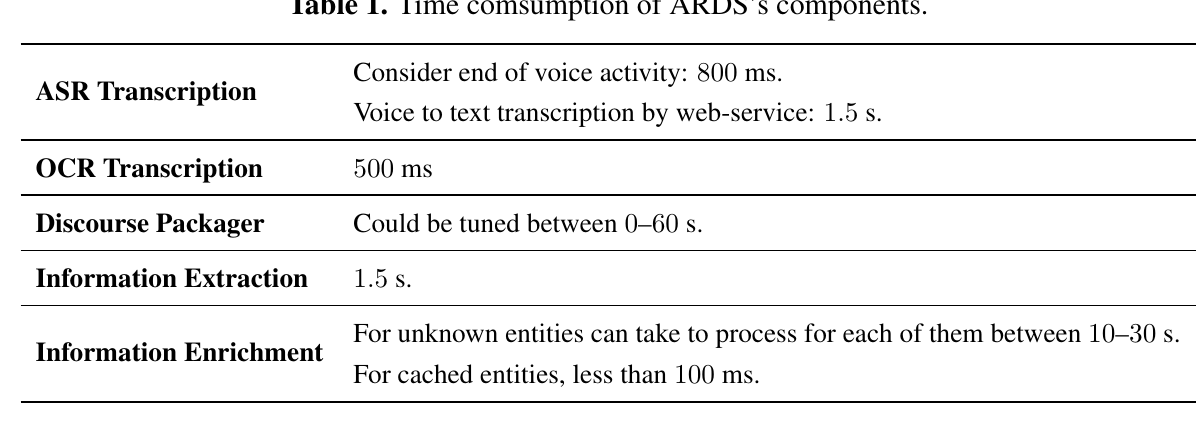
Table 1. Time comsumption of ARDS’s